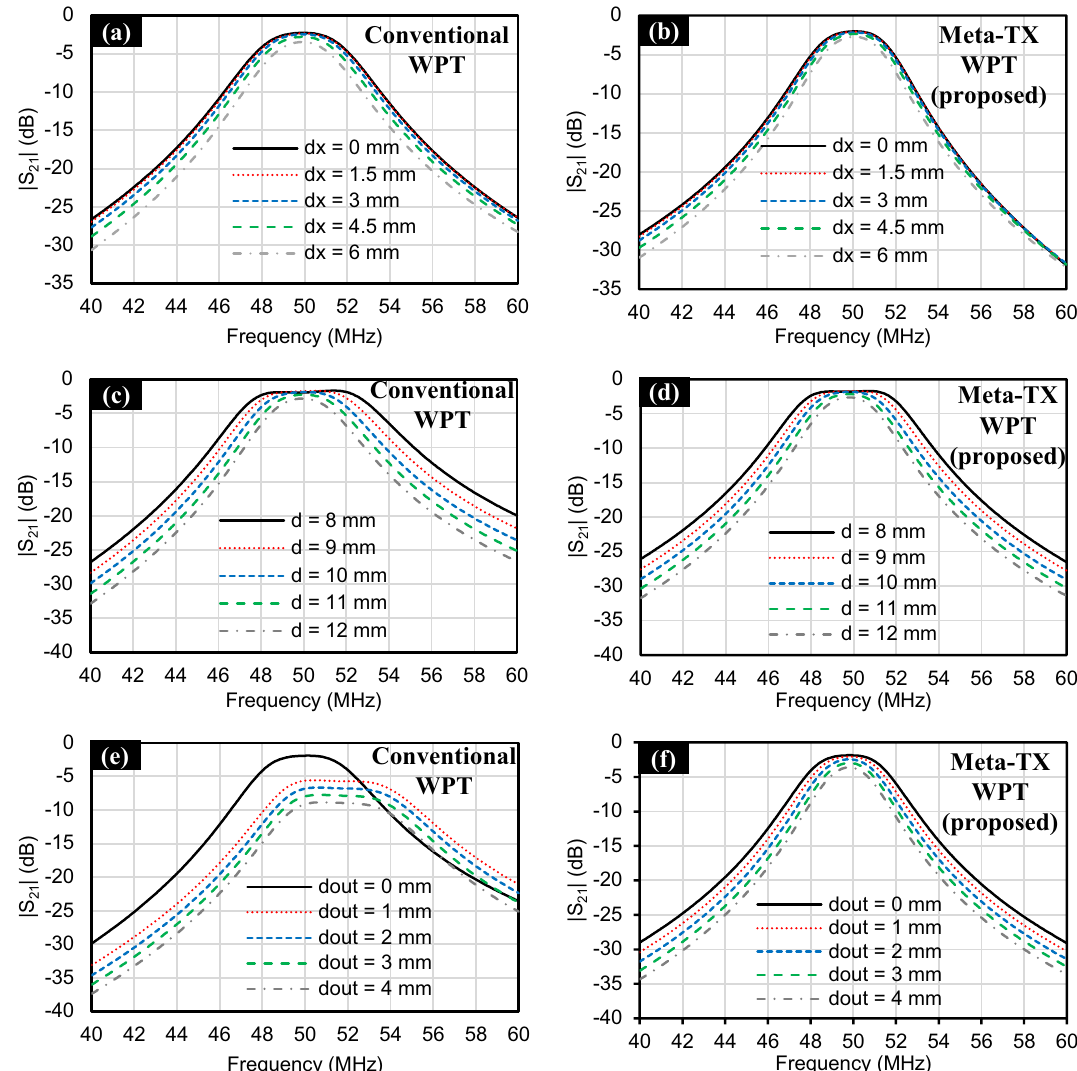
Figure 5. Simulated transmission coefficient (|S21|) of WPT systems during lateral misalignment: (a) Conventional. (b) Proposed; receiver separation misalignment inside the tissue. (c) Conventional. (d) Proposed; and transmitter separation misalignment from the tissue: (e) Conventional. (f)